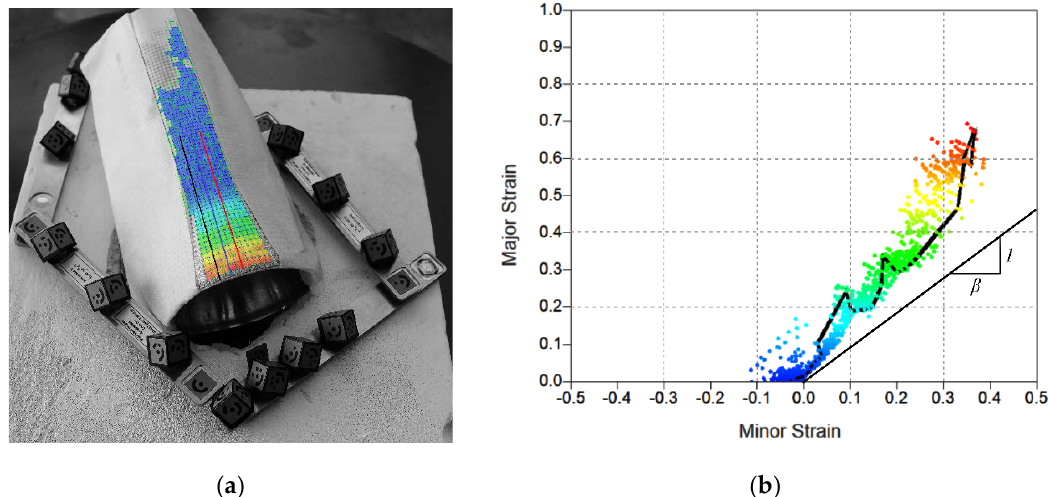
Figure 5. ( a ) Experimental determination of the in-plane strains by CGA using the automatic measuring system ARGUS ® , and ( b ) representation of these strains in principal strain space.